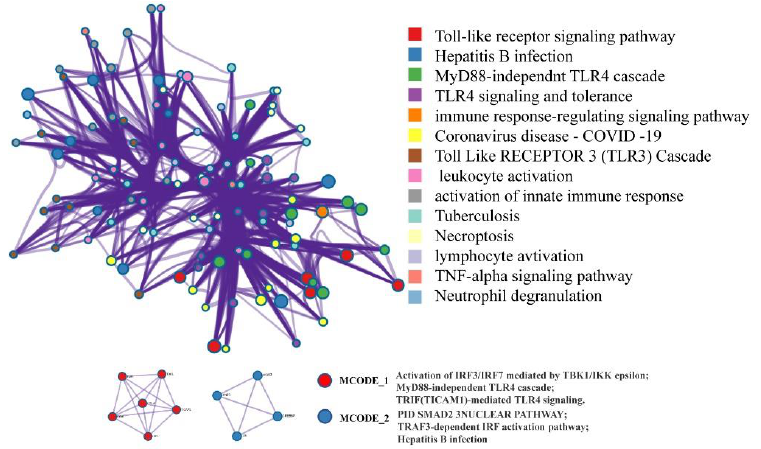
Figure 5. The PPI (Protein-Protein Interactions) network and MCODE classification of related genes in